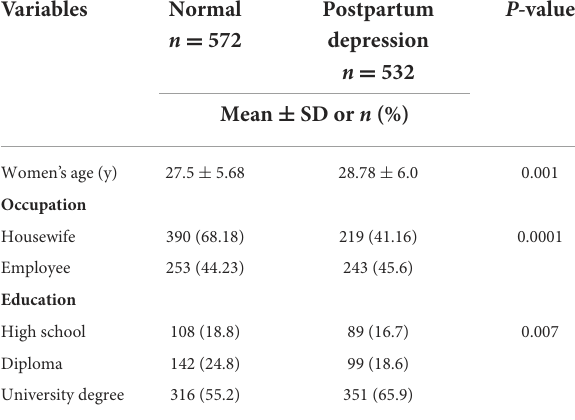
TABLE 2 Comparison of women with and without PPD before and after COVID-19 pandemic. Variables